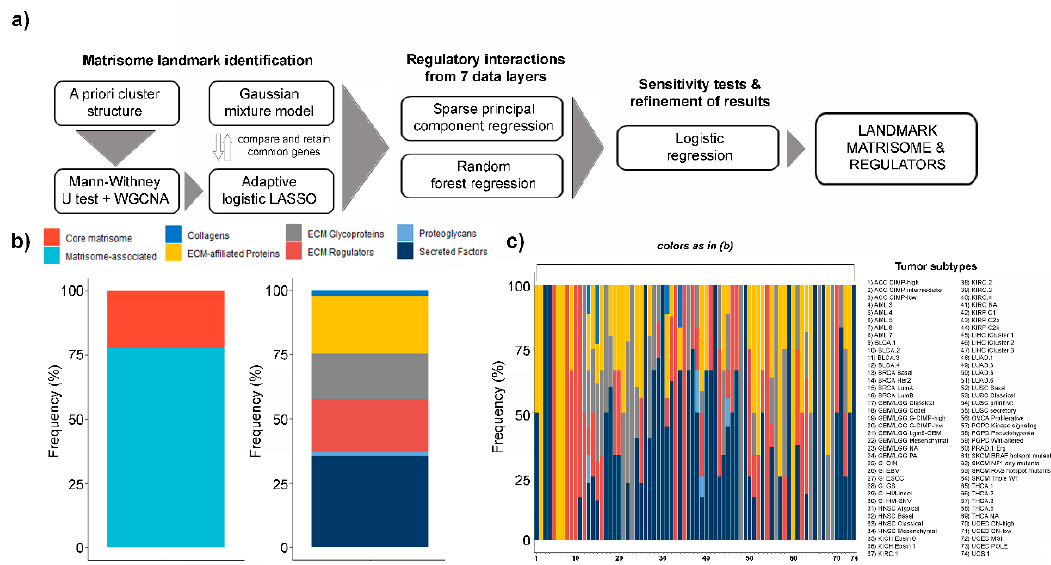
Figure 1. Landmark matrisome gene and regulators. ( a ) Pipeline for the identification of tumor subtype-specific (“landmark”) matrisome genes and their regulators; ( b ) % abundance of core and matrisome associated as well as collagens, extracellular matrix moieties (ECM)-a ffi liated proteins, ECM glycoproteins, ECM regulators, proteoglycans and secreted factors in landmark genes; ( c ) % abundance of interactions impinging on collagens, ECM-a ffi liated proteins, ECM glycoproteins, ECM regulators, proteoglycans and secreted factors, by tumor